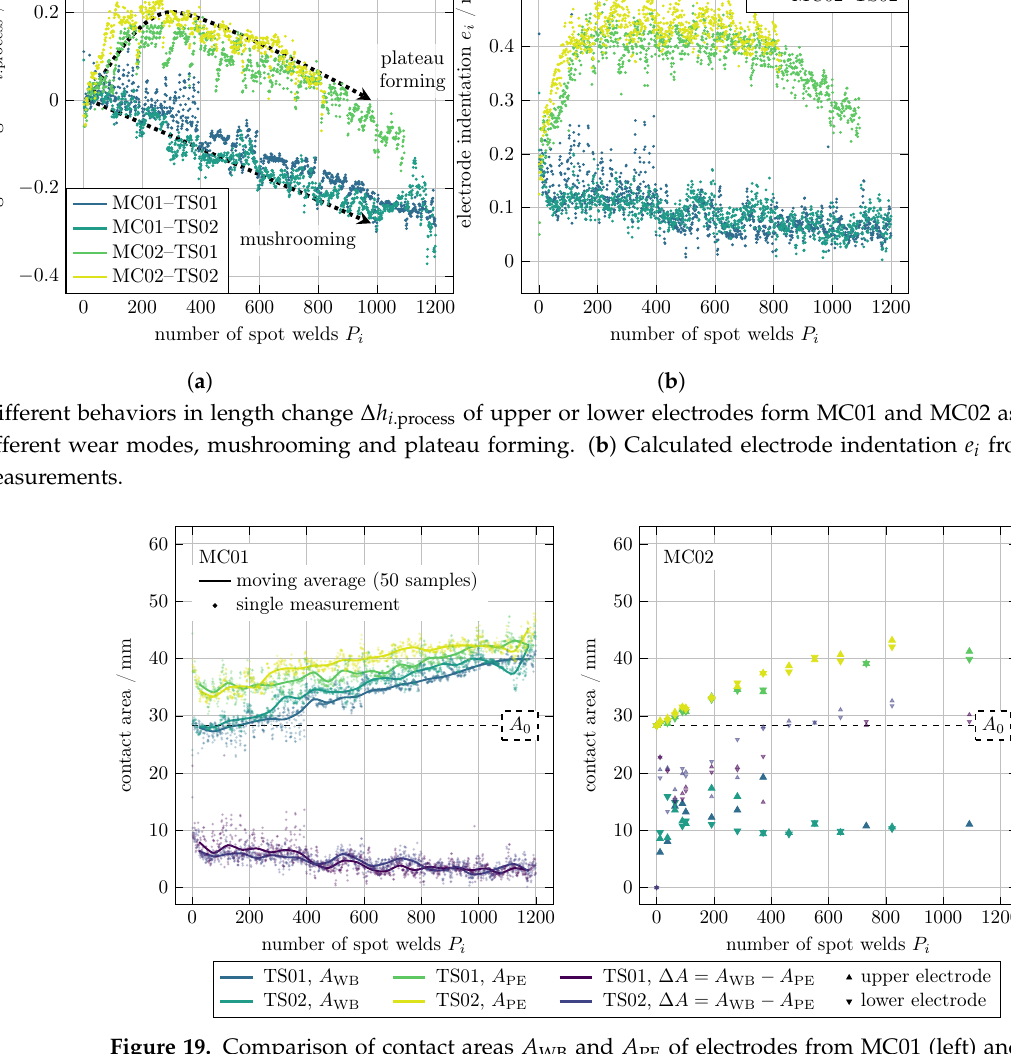
Figure 19. Comparison of contact areas A WB and A PE of electrodes from MC01 (left) and MC02 (right) as a result of two different wear modes, mushrooming and plateau